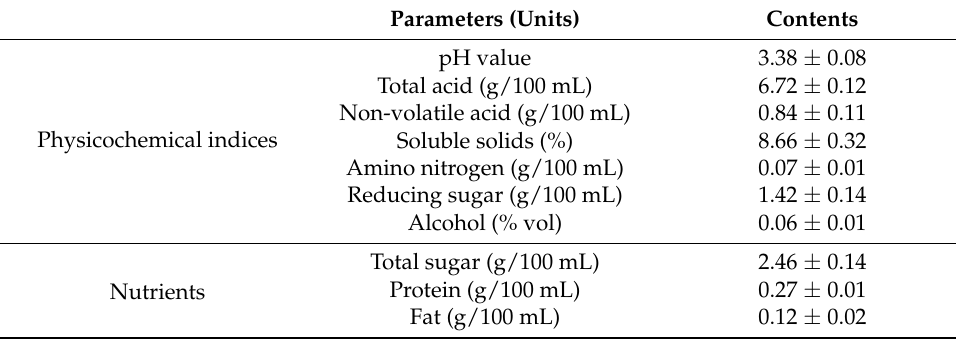
Table 1. Physicochemical indices and nutrients in